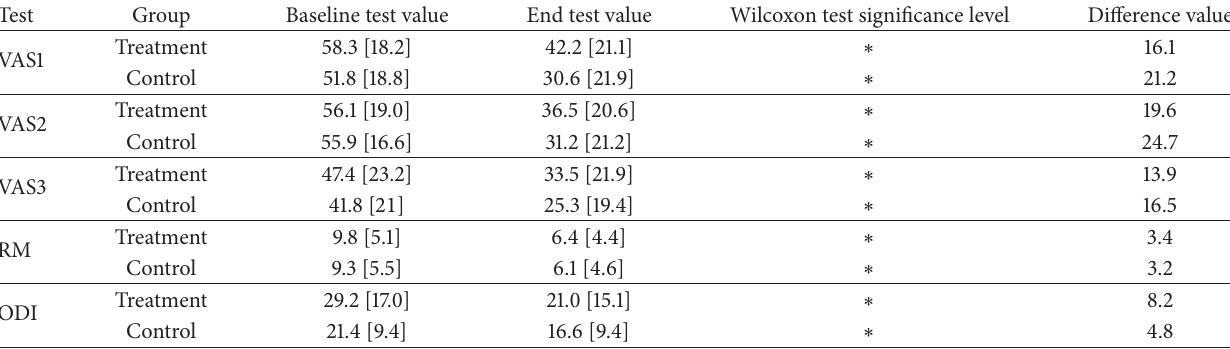
Table3:Resultsofthevisualanaloguescale(VAS),Roland-Morrisquestionnaire(RM),andOswestrydisabilityindex(ODI)beforetreatment (baseline test value) and after treatment (end test value).